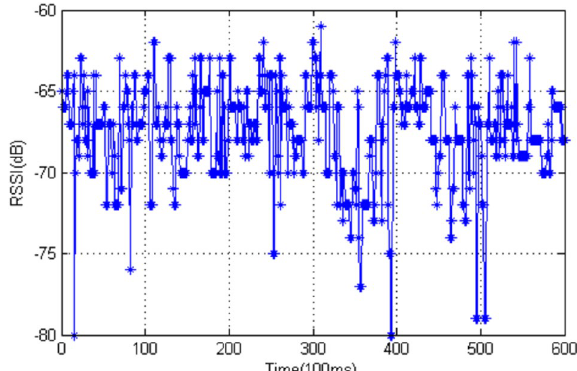
Fig. 1 Sample RSSI values in 1 m distance